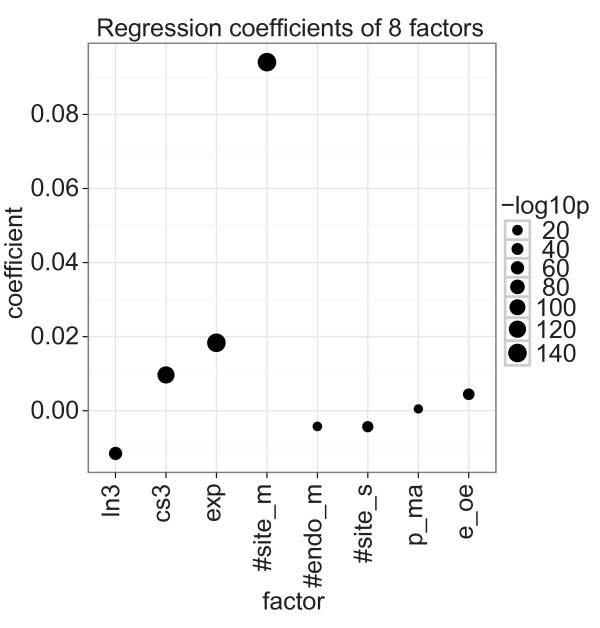
Coefficients of a linear regression with eight factors. The dot plot shows the coefficients of the liner model with formula: -log ratio = ln3 + cs3 + exp +#site_m + #endo_m + #site_s + p_ma + e_oe. The dot size shows -log10 of the coefficient's P-value. Positive coefficients associate with miRNA down-regulation. miRNA, microRNA.